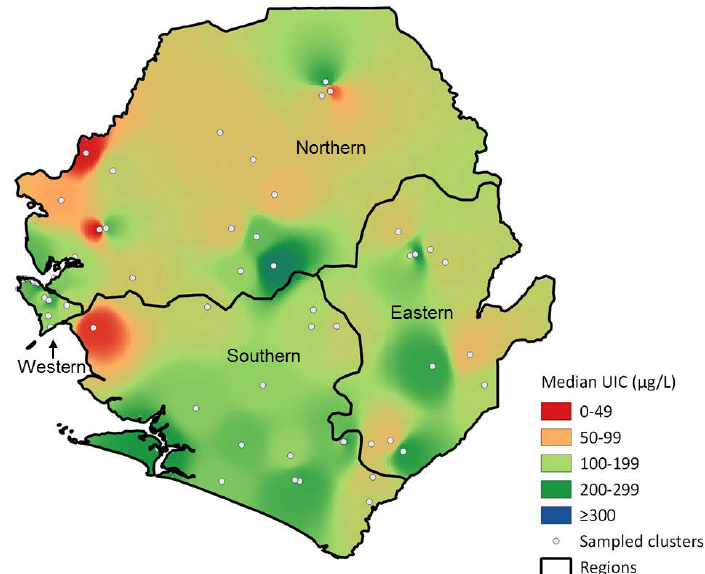
Figure 2. Geographic distribution of median urinary iodine concentrations among non-pregnant women aged 15–49 years, Sierra Leone, 2013.